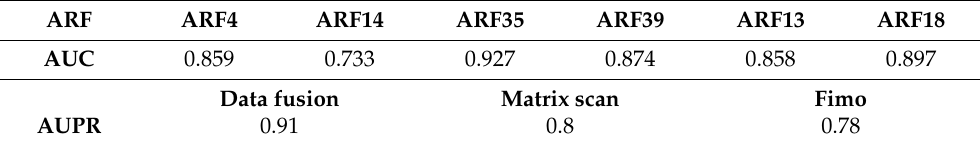
Table 2. Area under the receiver operator characteristic (ROC) curve (AUC) and average Area Under the Precision-Recall curve (AUPR) for six evaluated ARFs: ARF4, ARF14, ARF35, ARF39, ARF13, and ARF18.